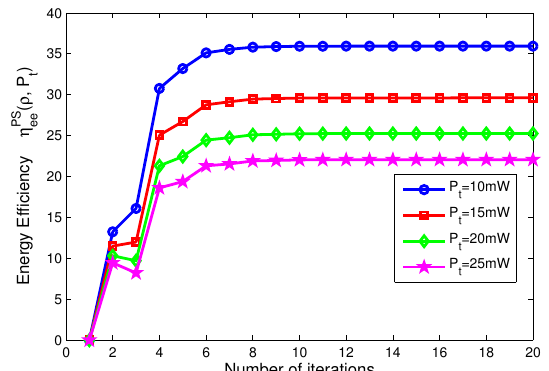
Figure 6. Energy efficiency versus number of iterations with different transmit power for PS mode.